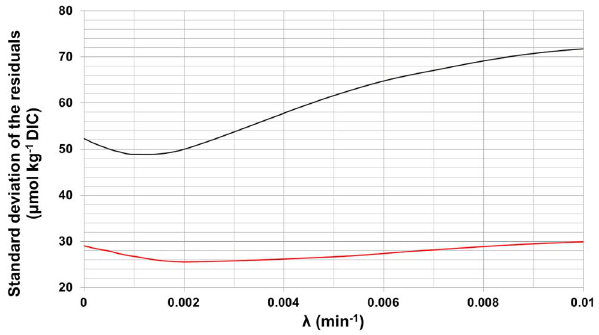
Figure 6. Sensitivity of the model to l . Evolution of the standard deviation of the residuals between model and observation in m mol kg 2 1 DIC in August (red) and September (black) as a function of l (min 2 1 ), the instantaneous rate of increase used for the exponentially weighted running integration of the irradiance